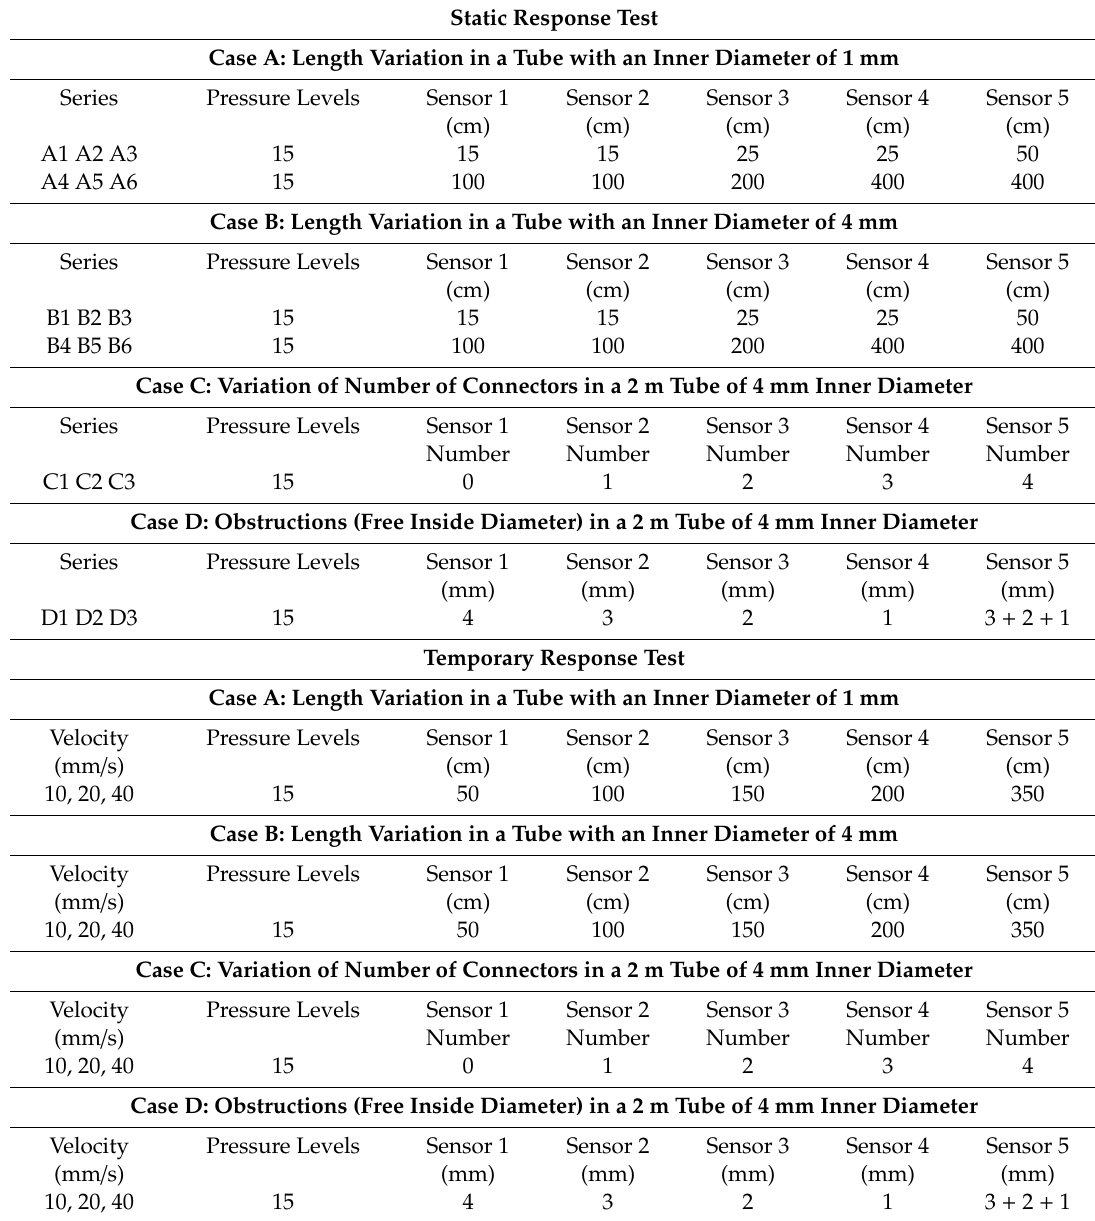
Table 2. Experimental cases and series. Static Response